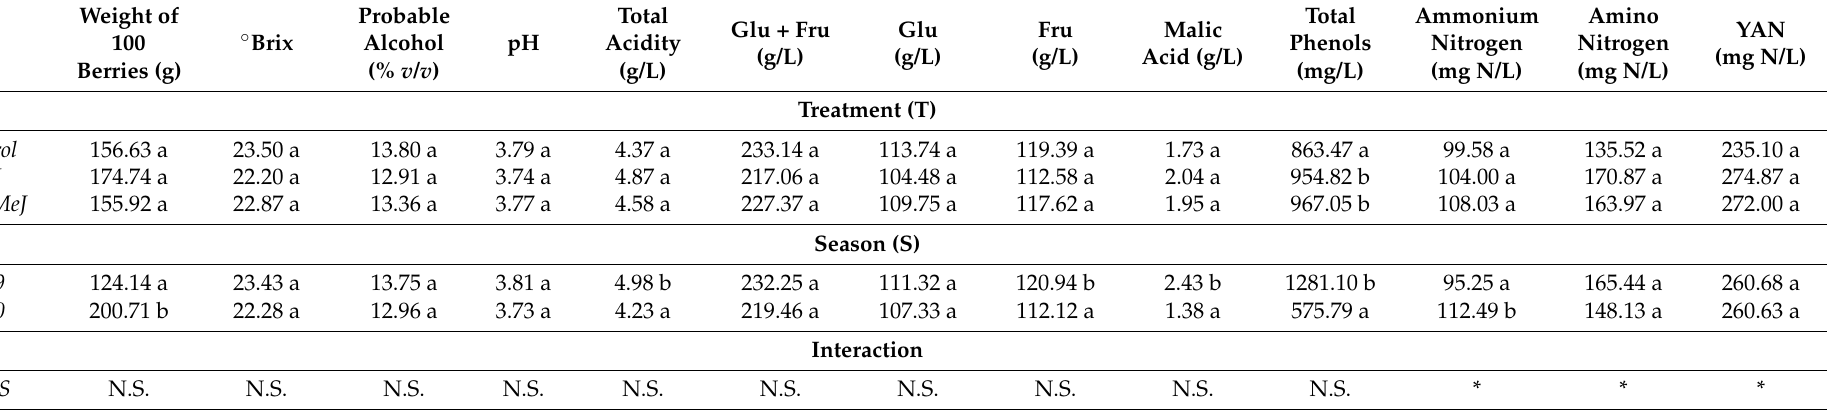
Table 3. Multifactor analysis of variance of general parameters of the musts with the two factors studied: treatment (control, MeJ, ACP-MeJ) and season (2019 and